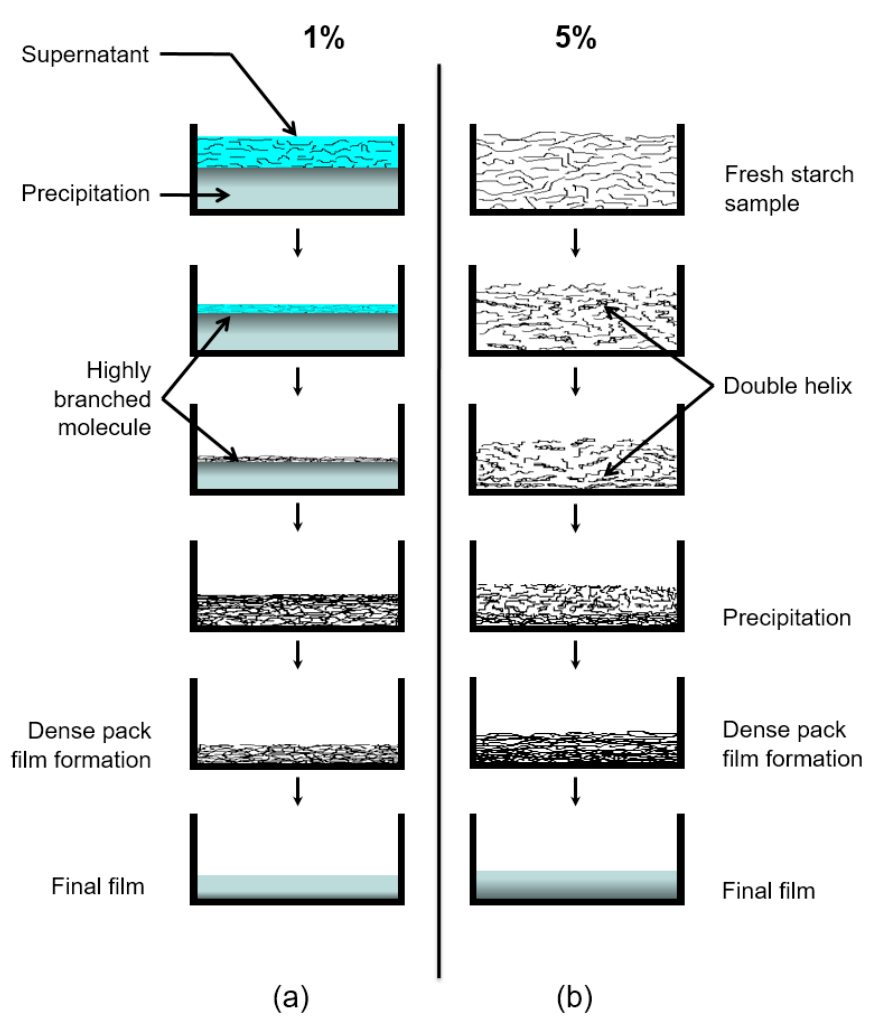
Figure 10. Illustration of a proposed mechanism for the starch film formation system at different stages of drying times. ( a ) Sample c containing 1% starch in H 2 O ( w/v ) and ( b ) Sample d containing 5% starch in H 2 O ( w/v ). The evolution time increases from top to bottom.